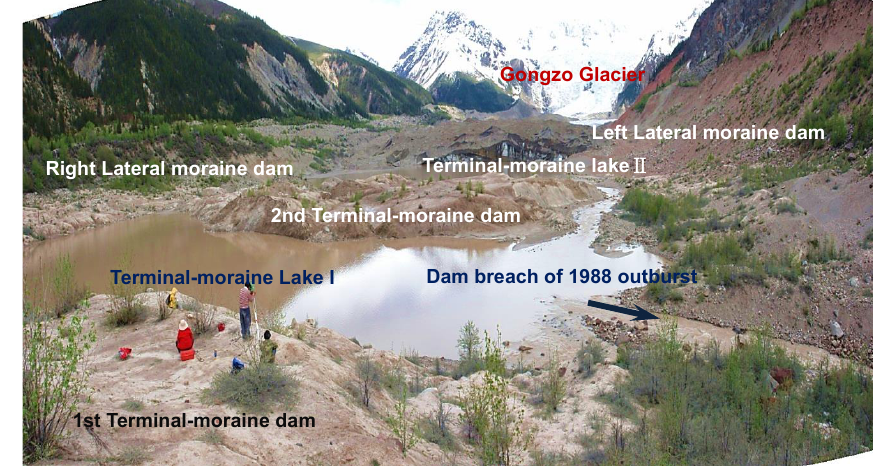
Fig.2. The photo of the Guangxieco Lake in 2007 Figure 2. The photo of the Guangxieco Lake in